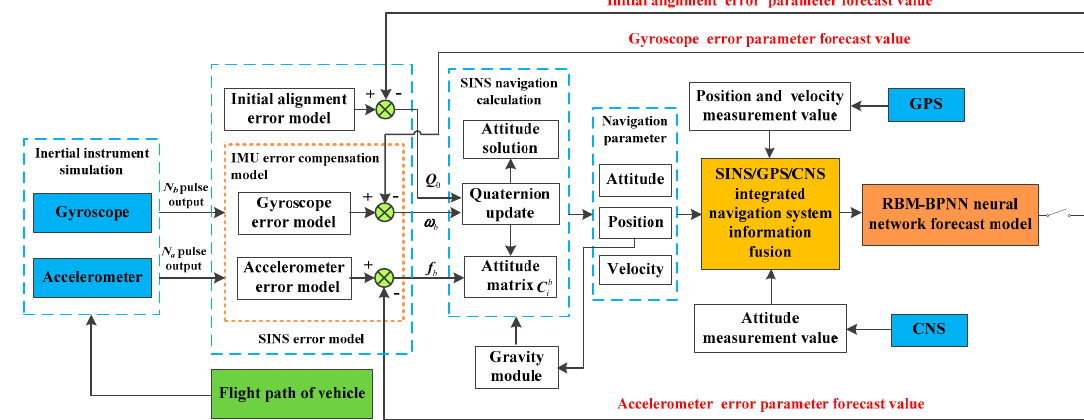
Figure 1. Overall error estimation scheme of RBM-BPNN